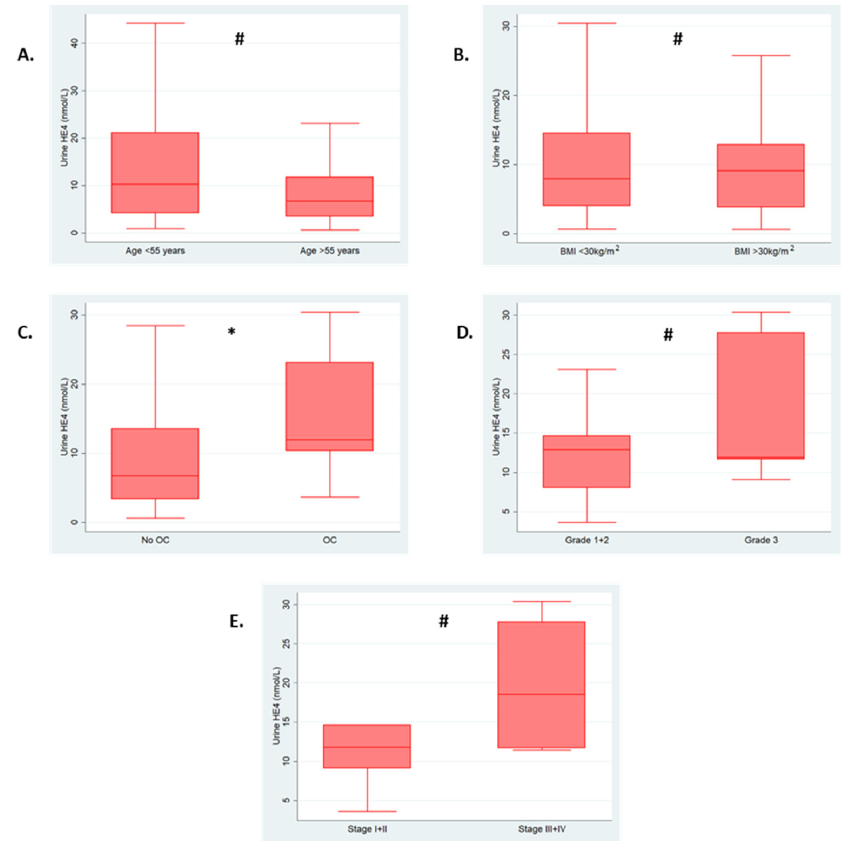
Figure 2. Box plots of urine HE4 (nmol/L) levels and clinico ‐ pathological features. ( A ) Age (<55 years vs. >55 years). ( B ) BMI (<30 kg/m 2 vs. >30 kg/m 2 ). ( C ) Disease status (no ovarian cancer vs. ovarian cancer). ( D ) Grade (low grade vs. high grade). ( E ) FIGO Stage (early stage vs. late stage). Significance calculated using Mann ‐ U Whitney test * p ‐ value < 0.05. # p ‐ value ≥ 0.05. Outliers excluded from plots. OC—ovarian cancer.